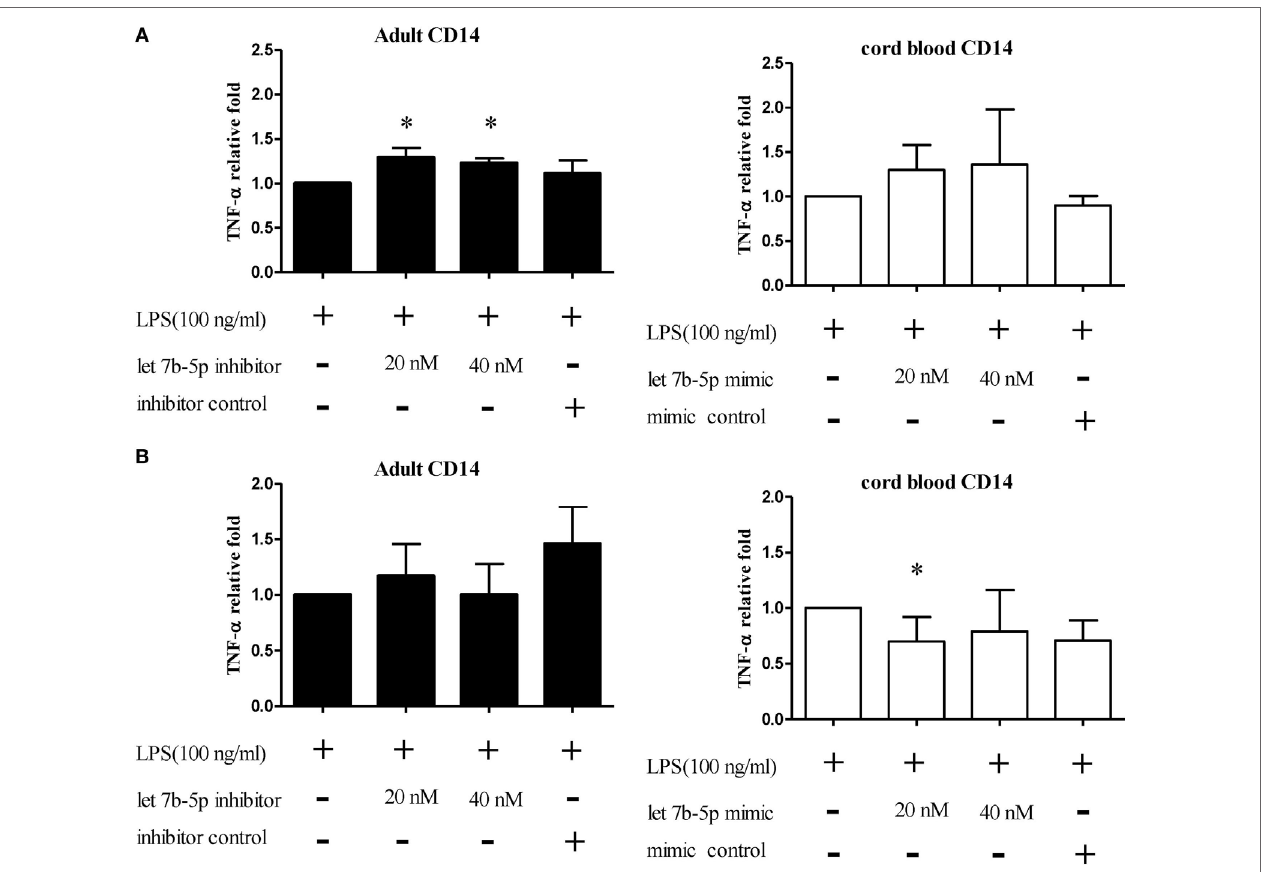
FigUre 14 | The effect of let-7b-5p on TnF- α production by monocytes . Adult monocytes with or without let-7b-5p inhibitor transfection and cord blood monocytes with or without let-7b-5p mimic transfection were subjected to detection of TNF- α protein after LPS stimulation for 16 h. The transfection times were (a) 24 h and (B) 48 h. TNF- α production is represented as relative fold expression compared to the LPS stimulation control. Data presented are calculated from five replicate measurements. * p < 0.05 as compared with LPS stimulation only with Mann–Whitney U test ( n =